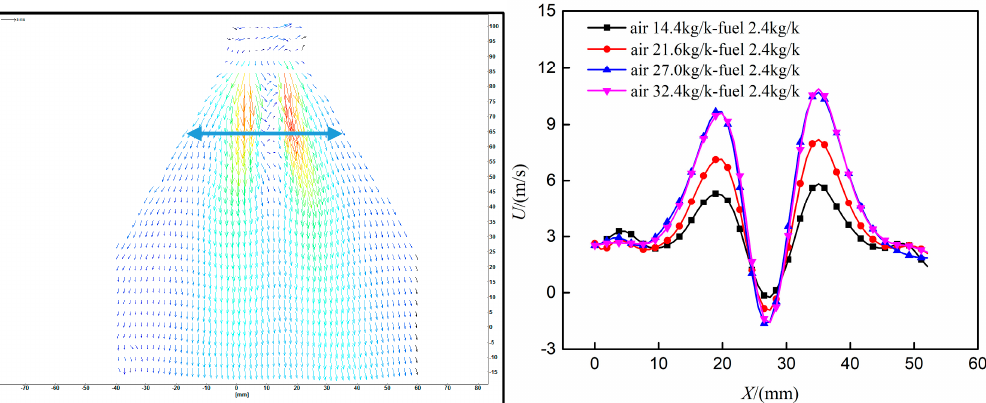
Figure 12. The influence of air mass rate on the axial velocity ( U ) at a distance of 20 mm from the swirler exit in Y direction (Case B).